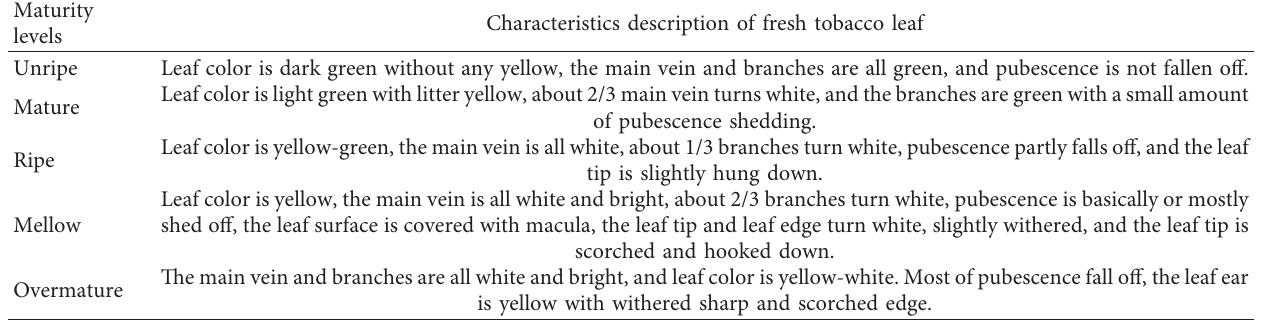
Table 1: The characteristics of fresh tobacco leaves in five maturity levels.